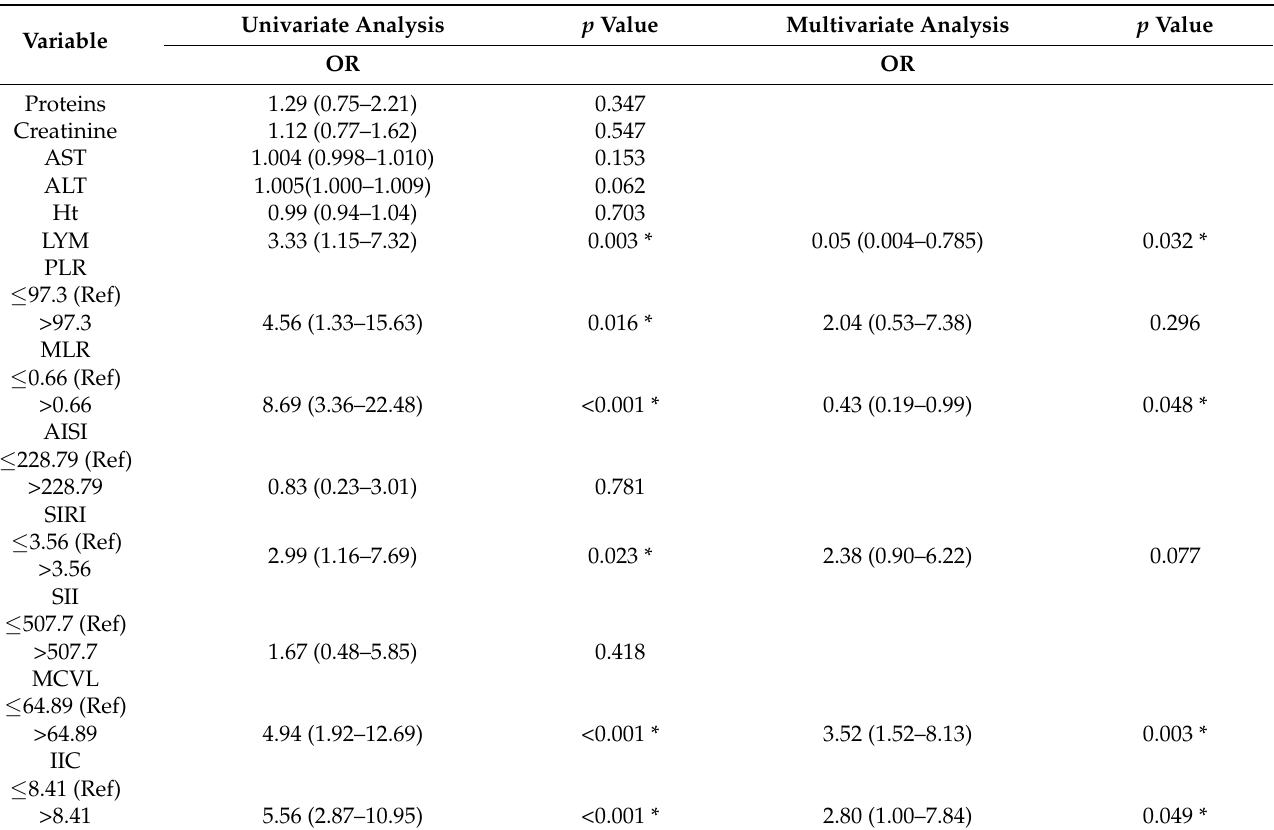
Table 9. Univariate and multivariate analyses of variables associated with complications in pre- COVID group.